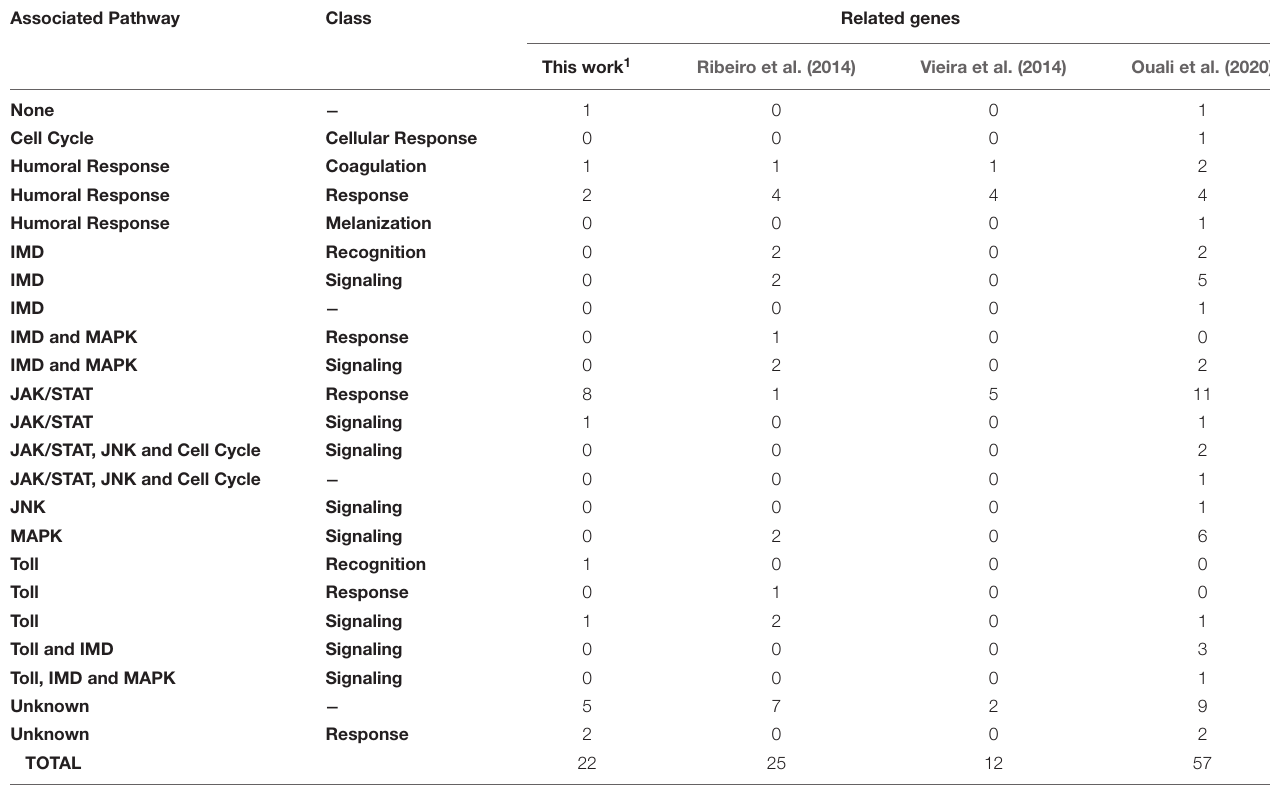
TABLE 3 | Pathways of the innate immune system from triatomines.